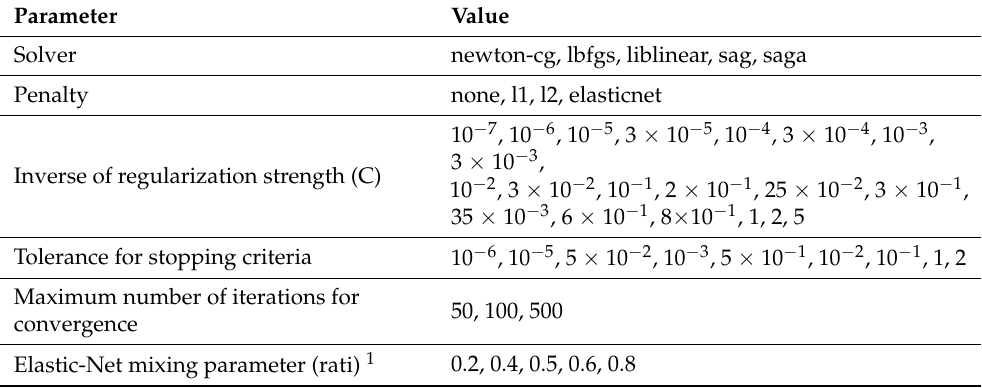
Table 6. LR parameters and their values used for grid search optimisation.